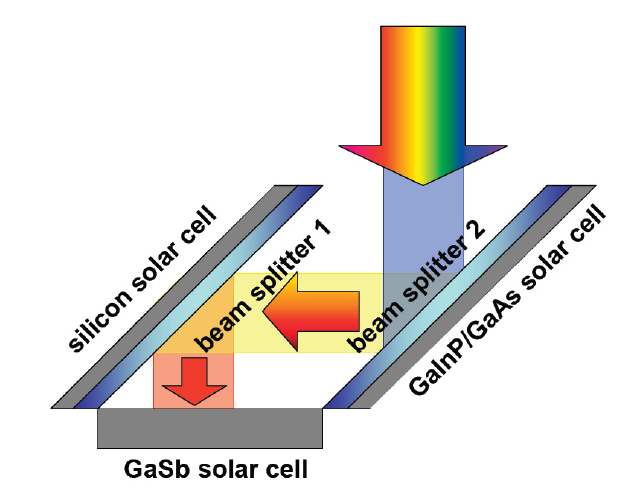
Figure 10. Arrangement of the prototype receiver using the geometry of a 45°-parallelepiped to build a light trapping, spectral beam splitting architecture including three solar cells (one dual junction- and two single junction solar cells) and two beam splitters. The beam splitters are positioned directly in front of the solar cells and are optically connected by a transparent layer of